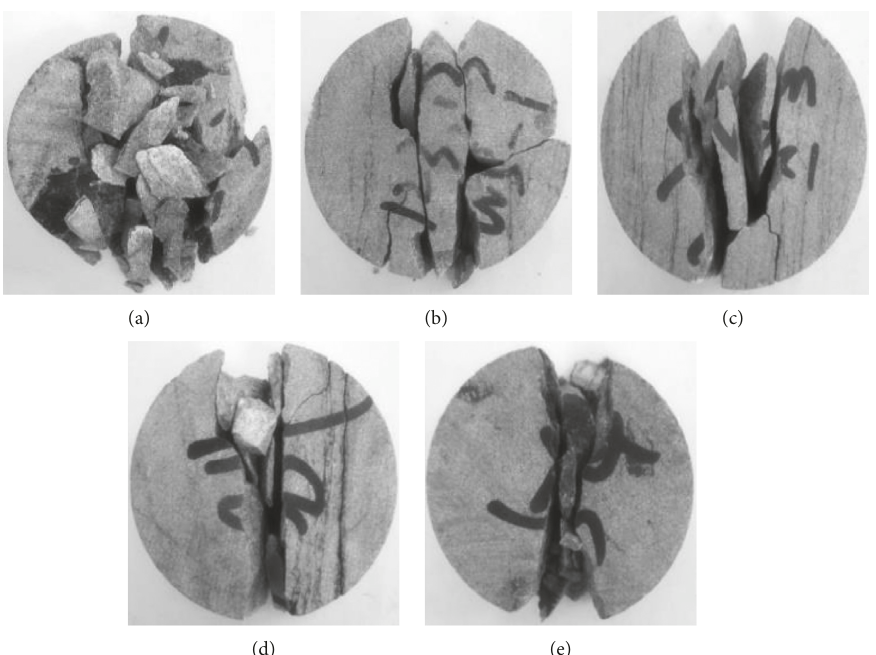
Figure 11: Failure of specimens with different water contents at a strain rate of 104.87s − 1 : (a) ω � 0.31%; (b) ω � 0.54%; (c) ω � 0.71%; (d) ω � 0.93%; (e) ω �